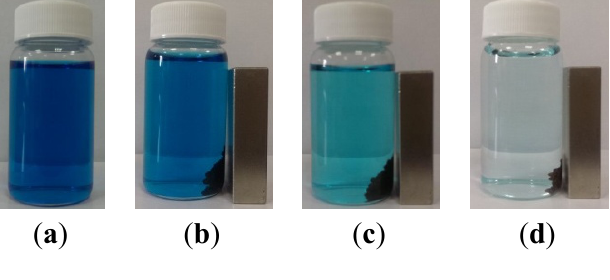
Figure 3. Photographs of malachite green dye treatment using magnetic P. sanguineus -loaded alginate composite beads: ( a ) original solution ( b ) baseline, ( c ) after 100 min of adsorption, and ( d ) after 1440 min adsorption.